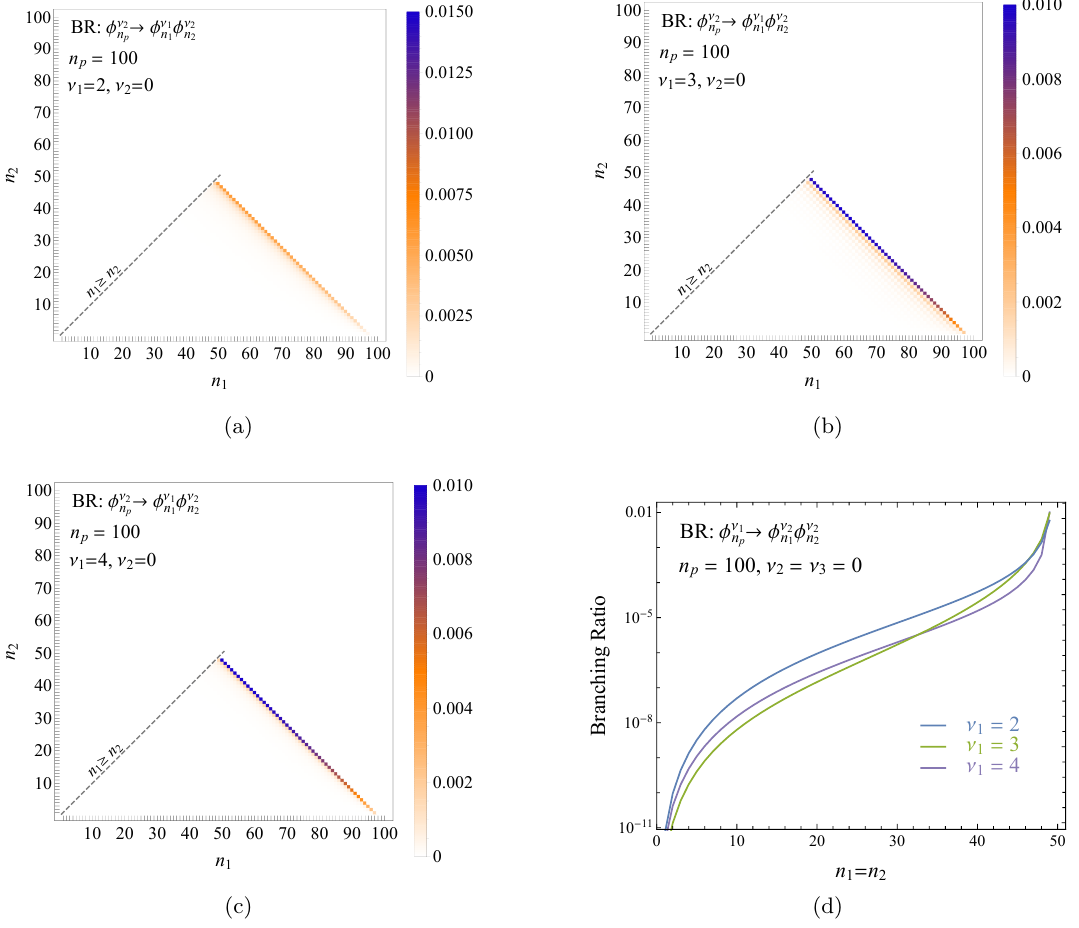
Figure 8 . The branching fraction triangle of the n p = 100 mode for the field corresponding to ν 2 = 0 into another ν 2 field and a (a) ν 1 = 2 , (b) ν 1 = 3 , or (c) ν 1 = 4 field. These decays do not exhibit the same plateau structure as in figure 7. The 1d projection of the branching ratios for all values of ν along the n = n line is given in 1 1 2